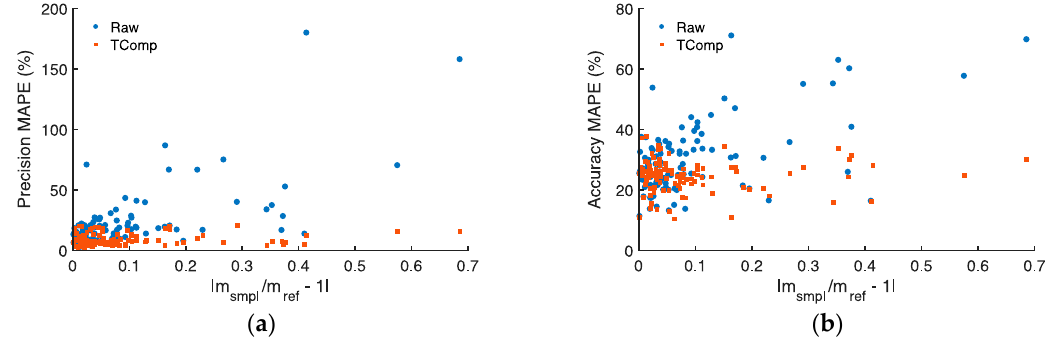
Figure 11. Mean absolute percentage error (MAPE) of uncompensated (Raw) and temperature-compensated (TComp) black carbon (BC) concentrations reported during field operation of 105 ABCD optical cells, as a function of the slope ratio’s absolute deviation from unity (|m smpl /m ref − 1|): ( a ) Precision MAPE evaluated relative to the mean ABCD response; ( b ) Accuracy MAPE evaluated relative to the AE33 reference instrument.